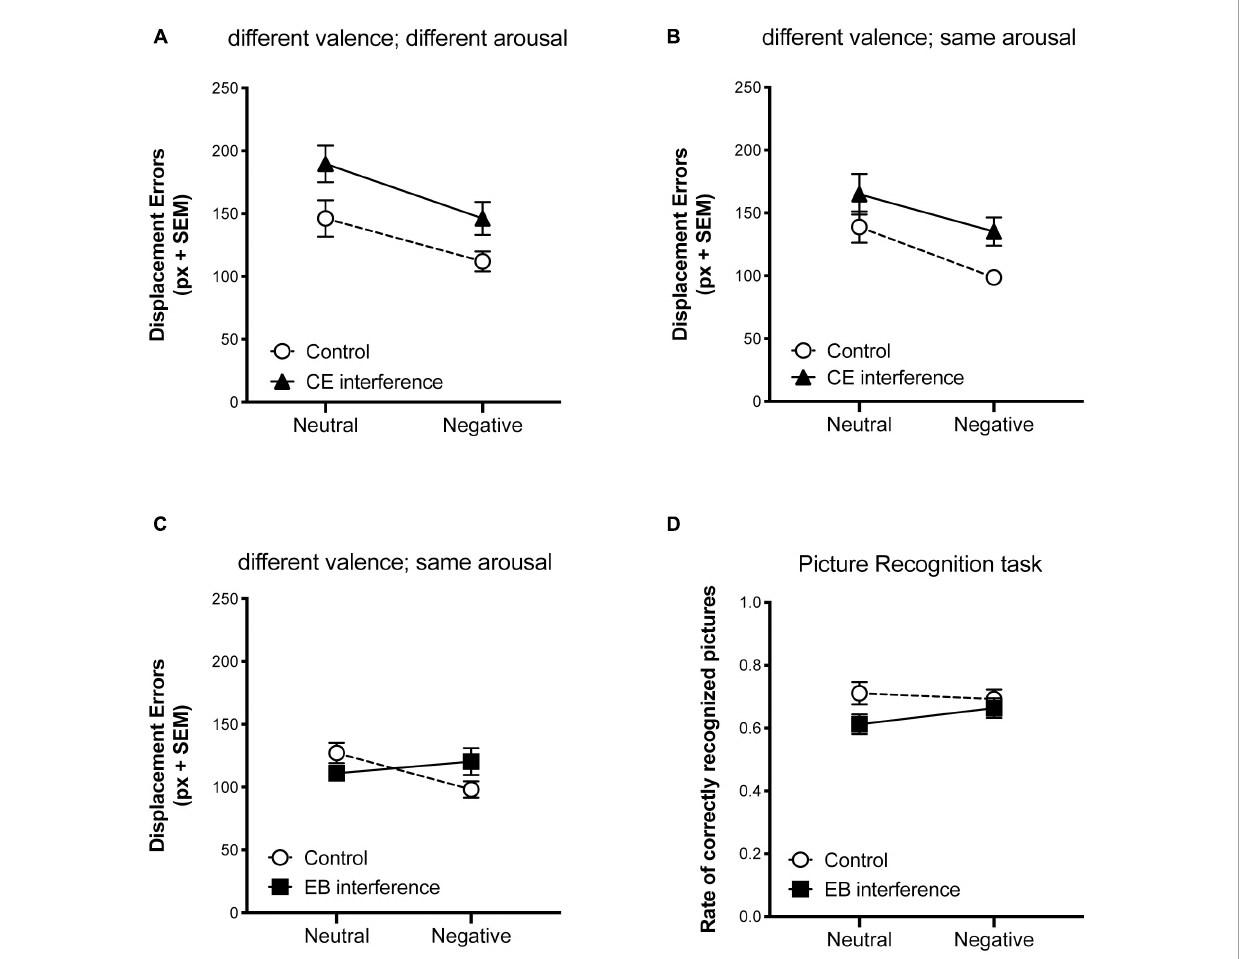
FIGURE2 Effect of interfering tasks on visuo-spatial working memory performance in the EORT. Mean displacement errors obtained in controls and in and central executive (CE interference) suppression conditions (A) when negative pictures presented during the encoding phase of the EORT were more arousing than neutrals and (B) when negative and neutral pictures had similar levels of arousal. (C) Mean displacement errors obtained in controls and episodic buffer (EB interference) suppression condition. (D) Rate of correctly recognized pictures presented during the encoding phase of the EORT in controls and episodic buffer (EB interference) suppression condition. Vertical bars represent